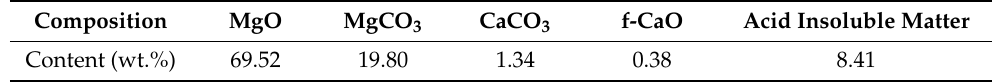
Table 2. Chemical composition of light burned